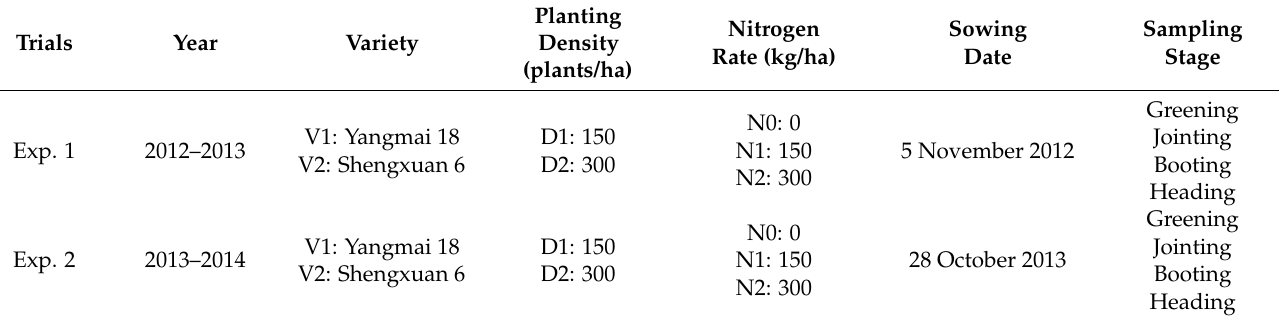
Table 1. The design of the two field trials.